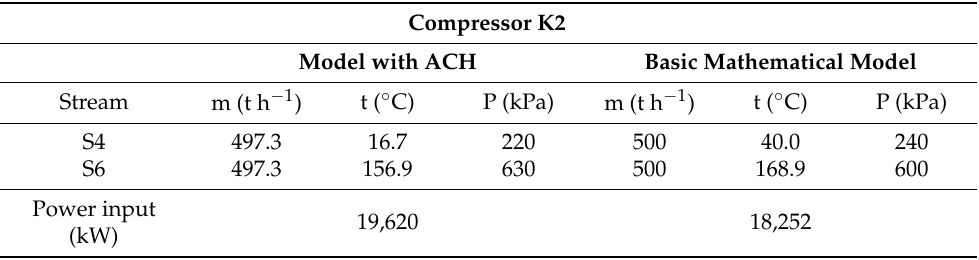
Table 6. Comparison of key parameters related to compressor K2 obtained by basic ASU model and by model comprising ACH.